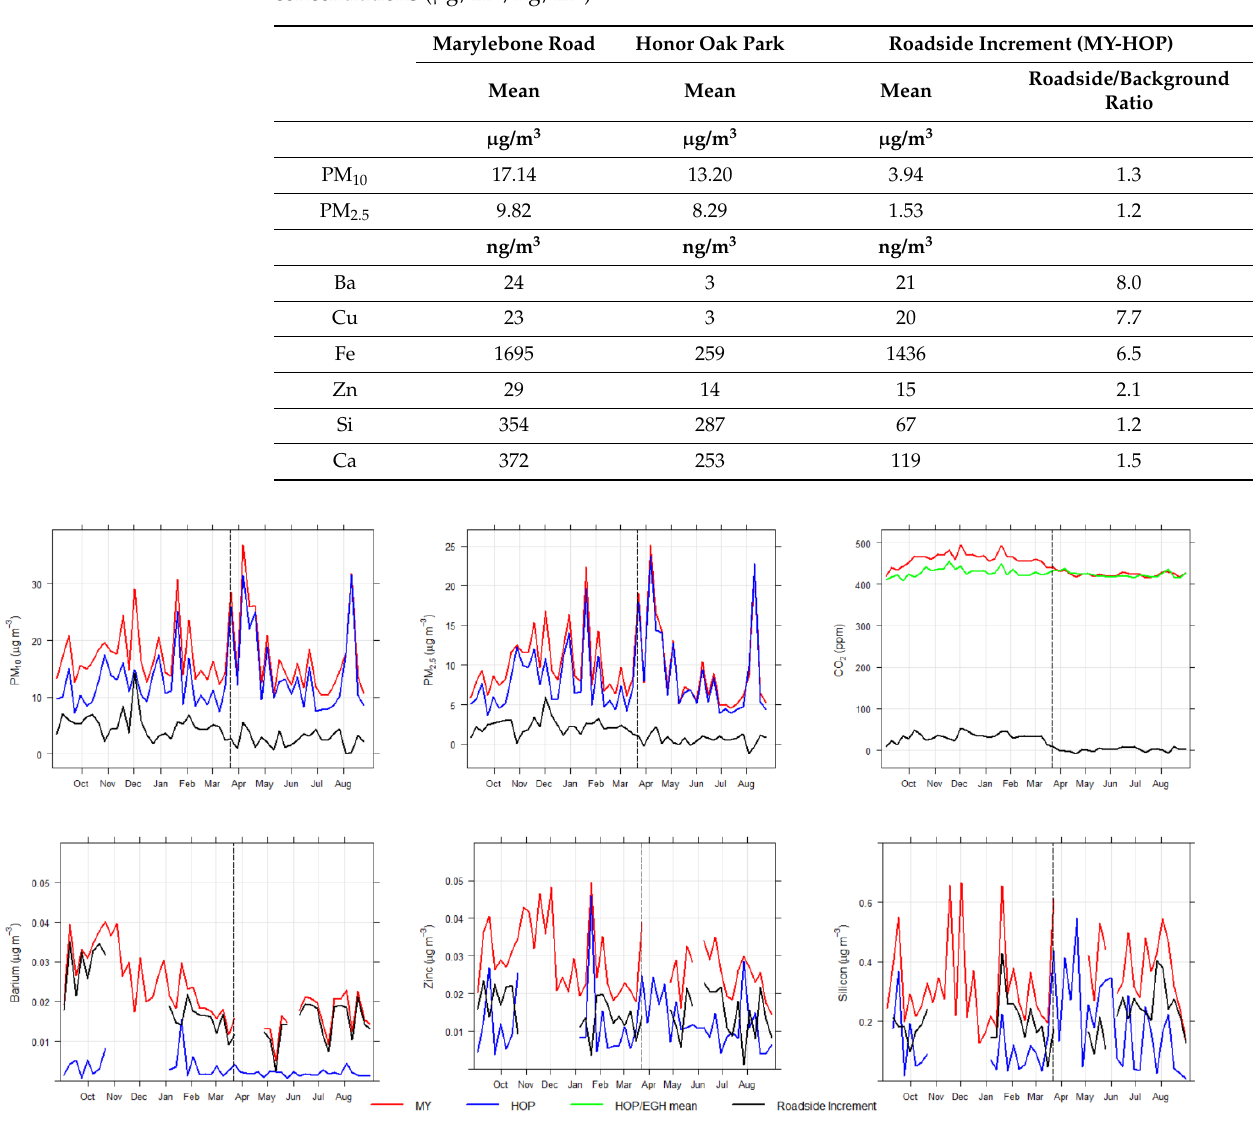
Figure 2. Weekly PM 10 , PM 2.5 , CO 2 , Ba, Zn, and Si roadside (MY), background (HOP and HOP/EGH mean), and increment (Roadside - Background) concentrations ( μ g/m 3 ). The plots show the concentrations across the year, with higher roadside increments generally occurring prior to lockdown (highlighted by the dotted vertical lines). Missing data are a result of instrument failure whilst fireworks periods are excluded.